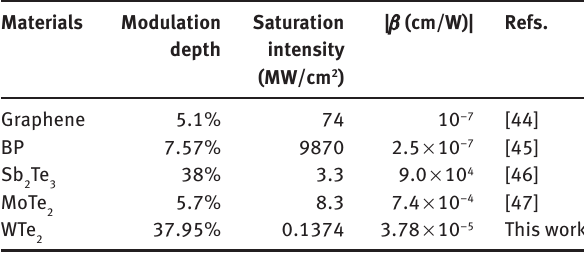
Table 1: The nonlinear behavior of some SAs.